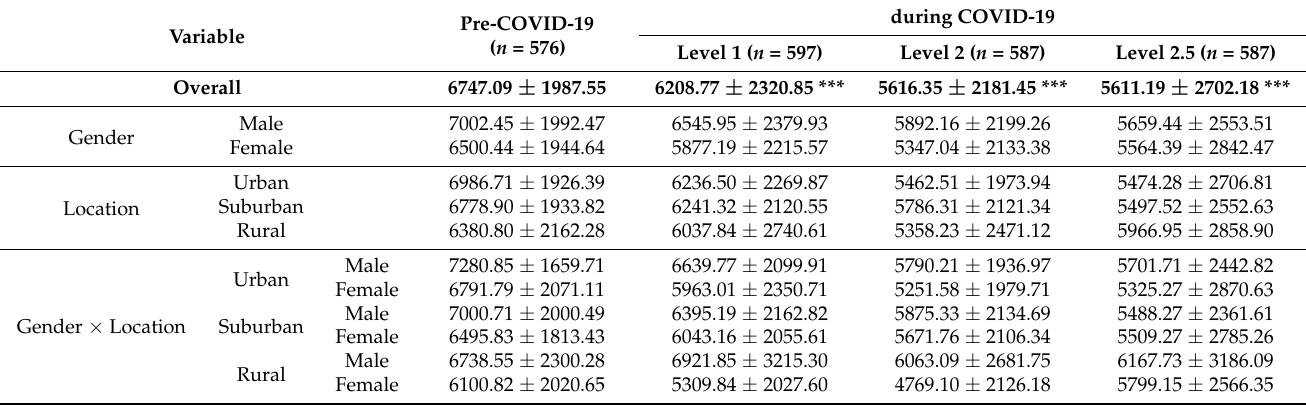
Table 2. Average daily step counts divided by gender, location, and gender × location in three different levels of social distancing (Mean ±